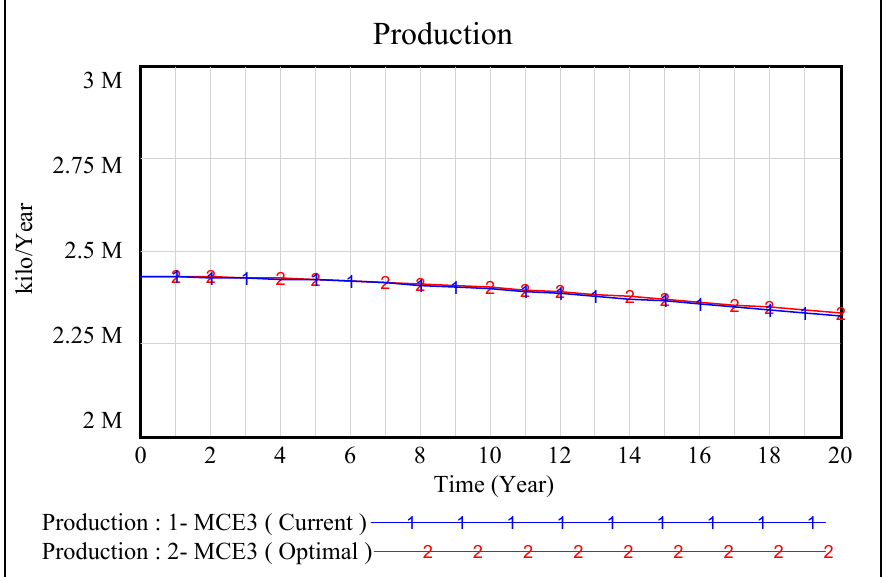
Figure 17. Comparison of the effect of the current and optimal amount of the obligatory omission rate 3 on milk production.